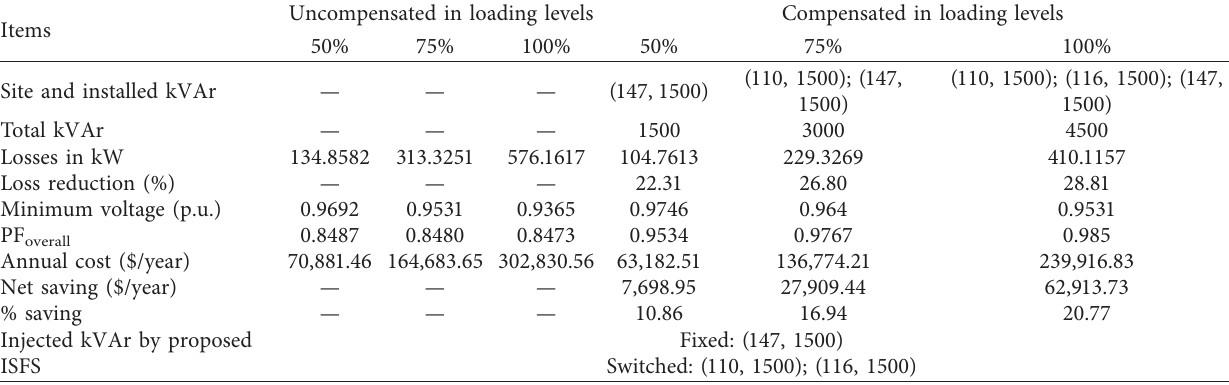
Table 11: Simulation results for 152-bus network at different loading conditions using proposed ISFS.